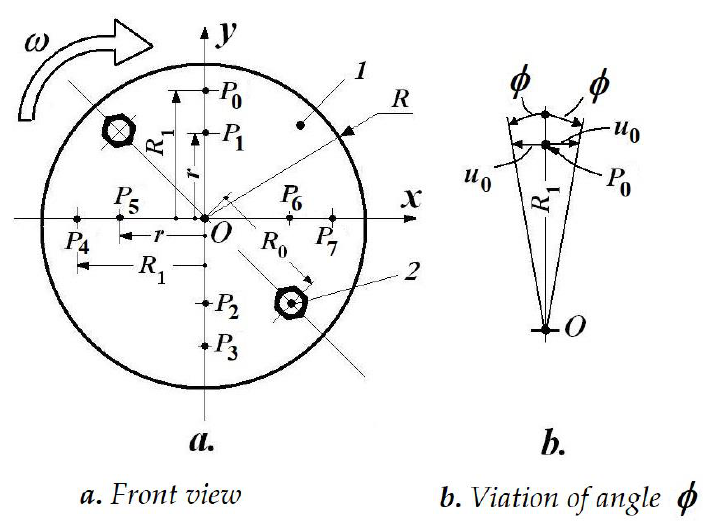
Figure 11. The frontal view of the monitored disk 4.